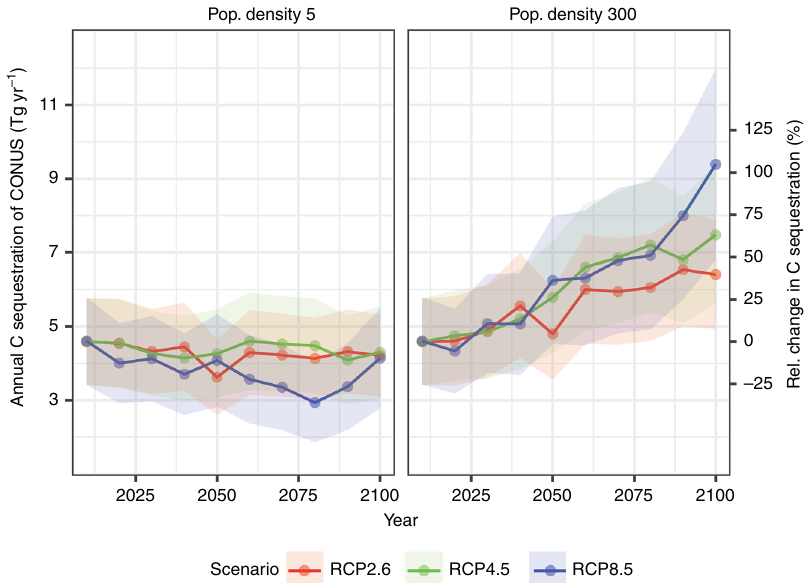
Fig. 7 Estimation of total annual C sequestration of the conterminous United States tidal wetlands to 2100 based on tidal wetland area changes estimated by and projected CAR based on future RSLR under RCP 2.6, RCP 4.5, and RCP 8.5 scenarios. The colored shadow is the probability distribution between